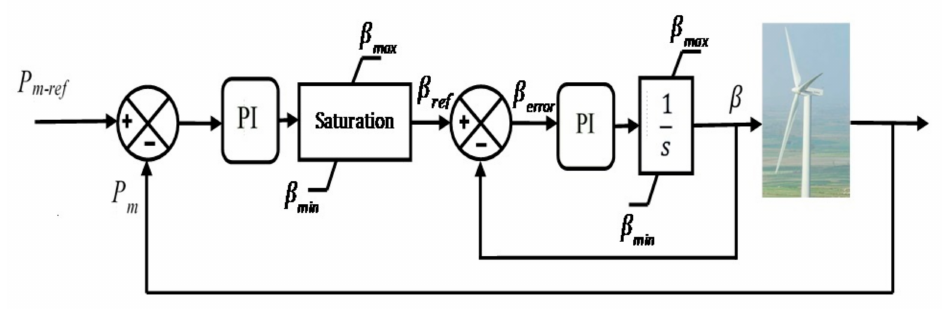
Figure 3. Block diagram of the pitch angle